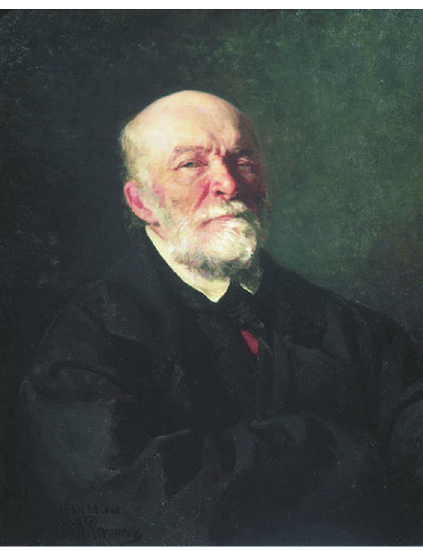
Figure 1: Nikolai Iwanowitsch Pirogow painted by Ilja Jefimowitsch Repin, 1881.